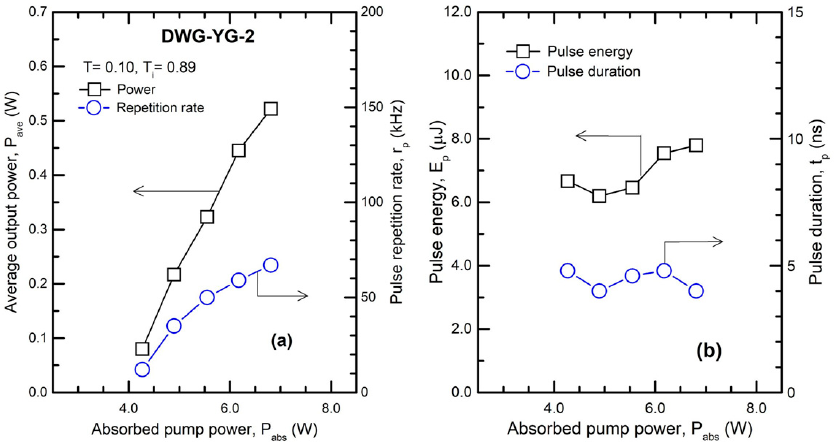
Figure 4. Q-switch operation for waveguide DWG-YG-2 and Cr 4+ :YAG with T i = 0.89: ( a ) Average